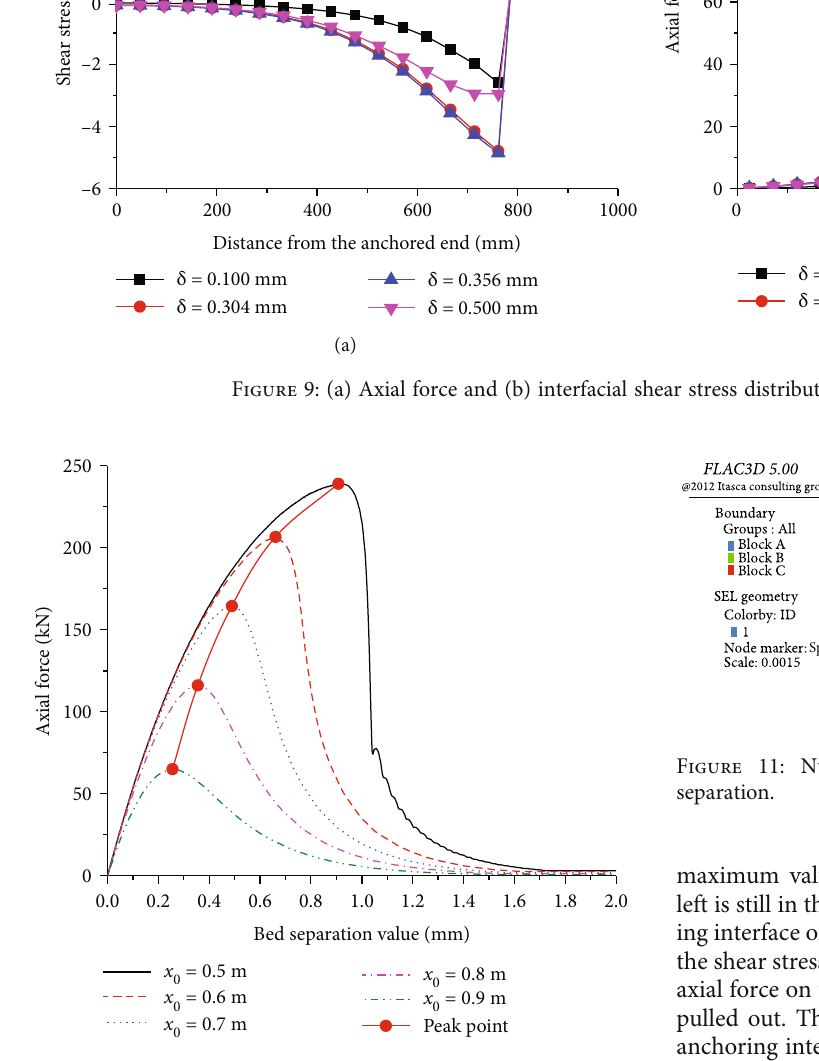
Figure 10: Comparison curves of axial force versus the bedding separation value at di ff erent bedding separation positions.